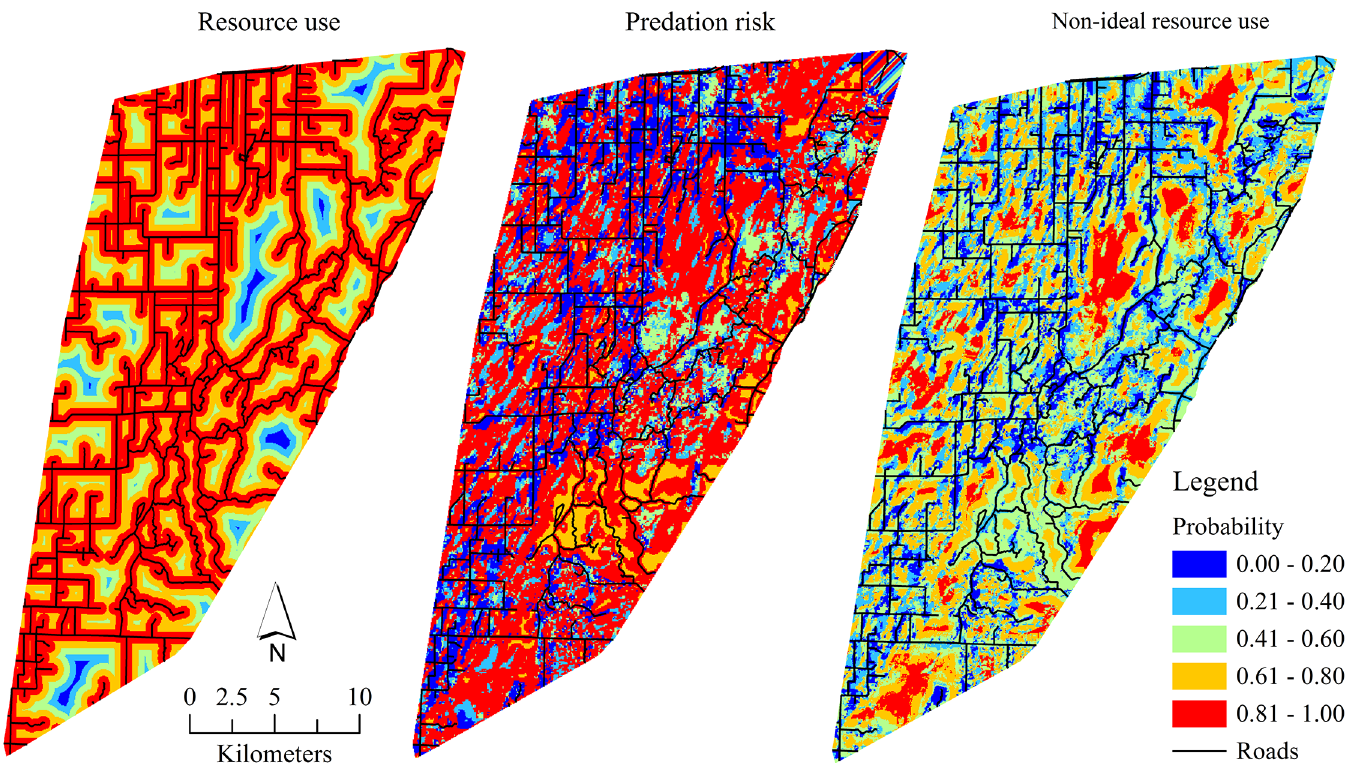
Fig 3. Spatially-predicted probability of resource use, integrated predation risk, and non-ideal resource use for white-tailed deer fawns ( (cid:1) 14 weeks old; Odocoileus virginianus ; n = 129) captured as neonates during the maternal dependency period (25 May – 31 August), Upper Peninsula of Michigan, USA, 2009 – 2011. Integrated predation risk was estimated from the summed probability of resource selection of bobcats ( Lynx rufus ), American black bears ( Ursus americanus ), coyotes ( Canis latrans ), and gray wolves ( C . lupus